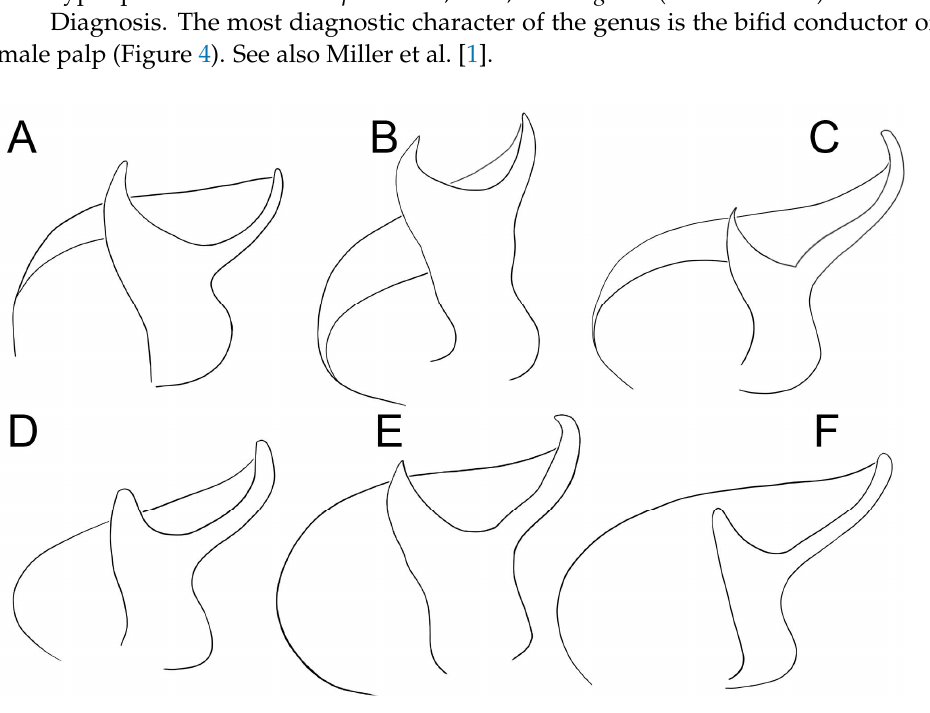
Figure 5. Distribution of Loureedia . Color codes: yellow— L. colleni , blue— L. maroccana, white— L. lucasi , green— L. jerbae , khaki— L. annulipes ( SAJ264 not shown), magenta— L. phoenixi ., black dot— unidentified Loureedia specimen from Jordan [7]. Loureedia annulipes (Lucas, 1857) Figures 1A,B, 2E, 4C, 5, 6C, 7C and 8C.